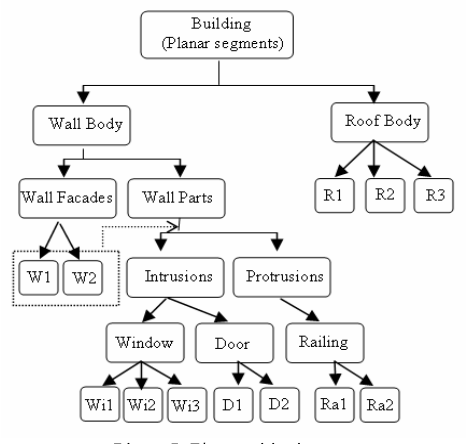
Figure 5: The partitioning tree